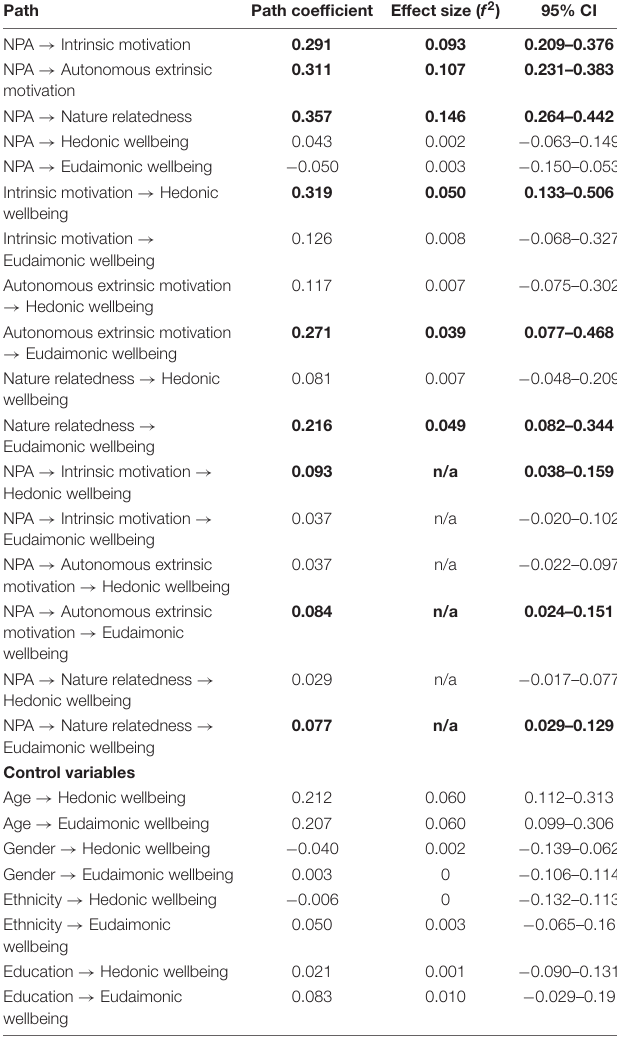
TABLE 3 | Path estimates amongst